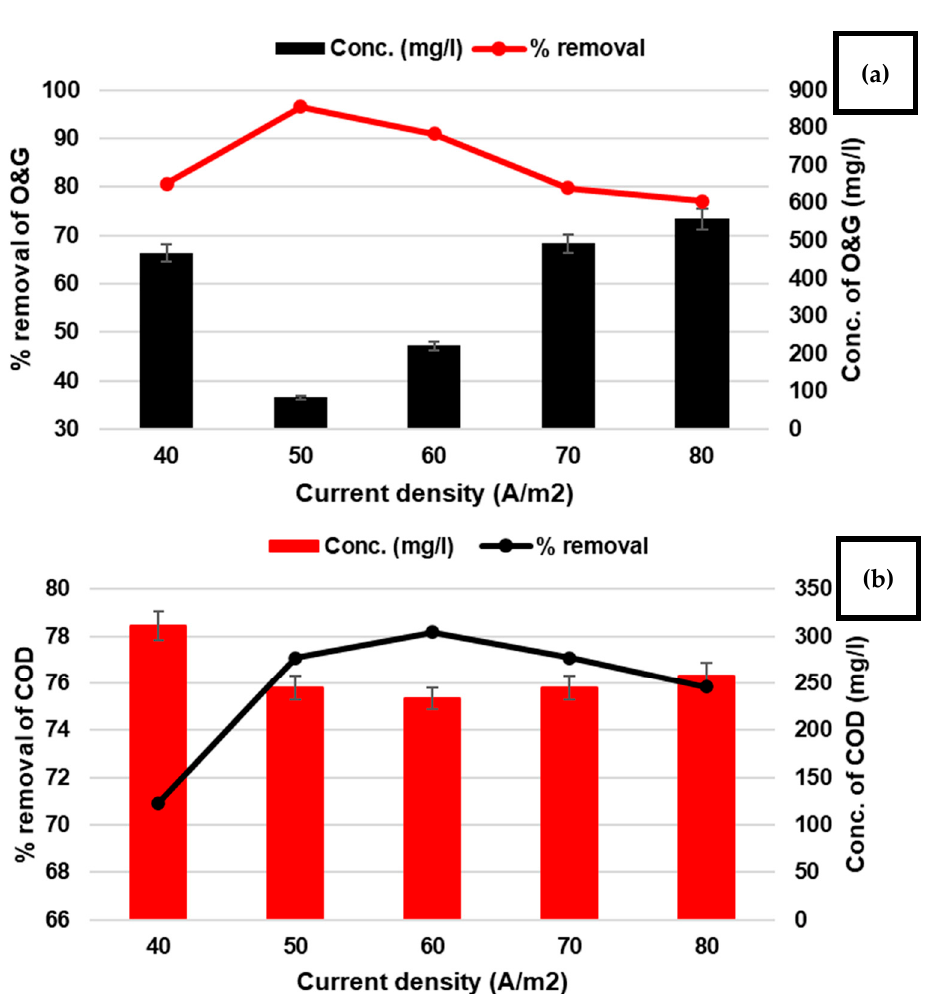
Figure 5. The effect of CD on the (%) removal efficiency and concentration of ( a ) O&G and ( b ) COD using the EC process with a constant interelectrode distance of 2 cm and a 30 min electrolysis time.